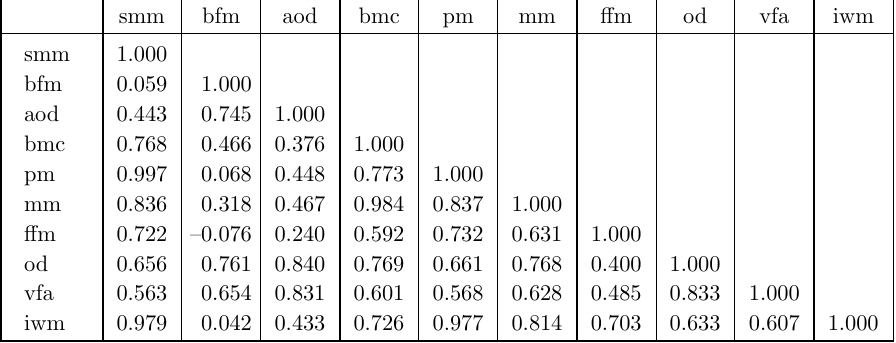
Table 7. Correlation matrix of ten musculoskeletal parameters smm bfm aod bmc pm mm